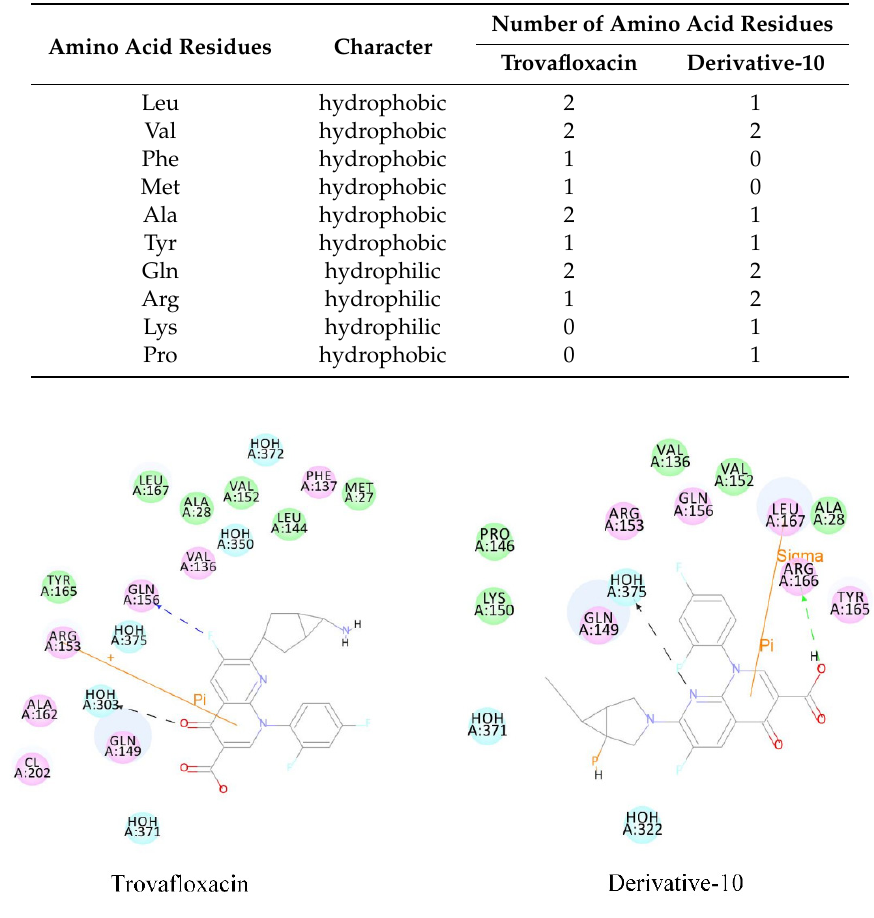
Table 8. Distances between trovafloxacin and derivative-10 and hydrophilic amino acid residues at the plasma protein binding